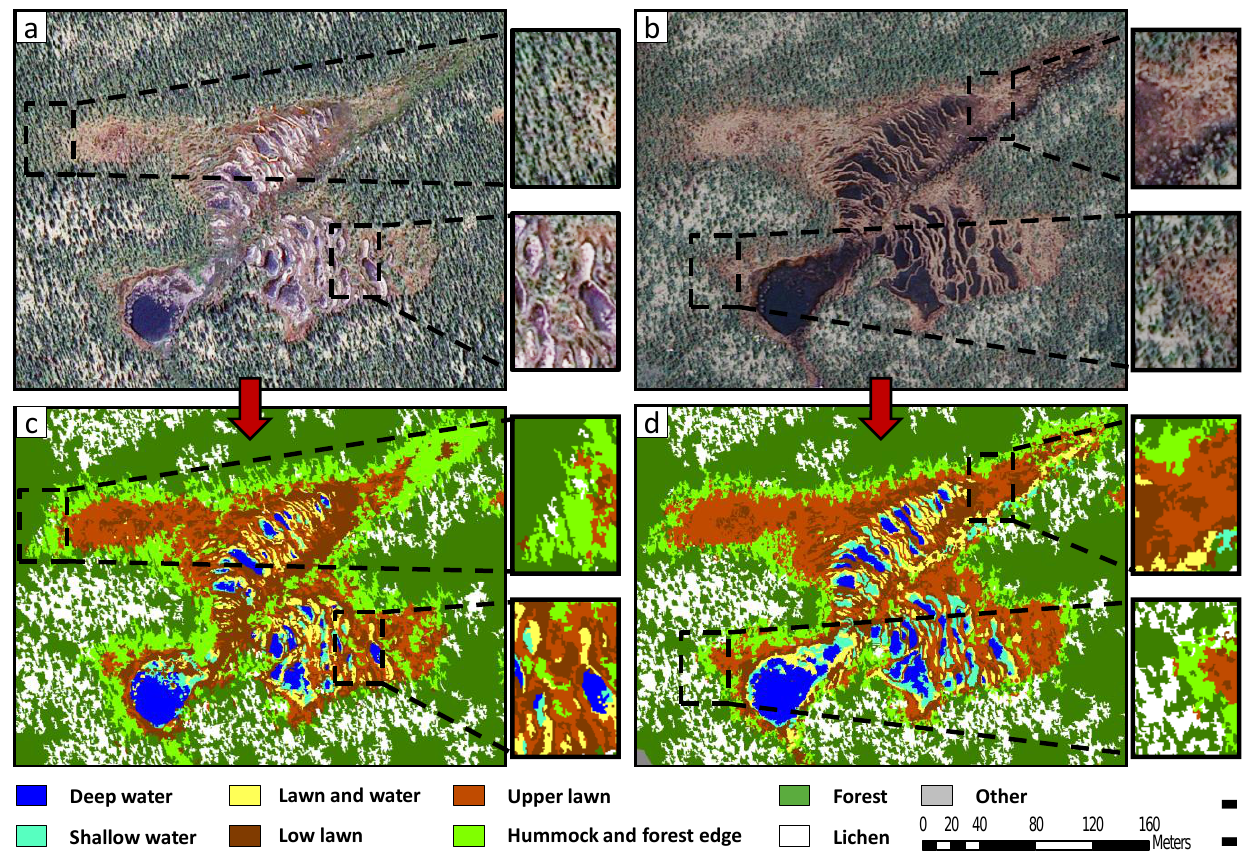
Figure 5. Comparison between ( a ) 23 July 2009 and ( b ) 18 May 2010 RGB images (subsets